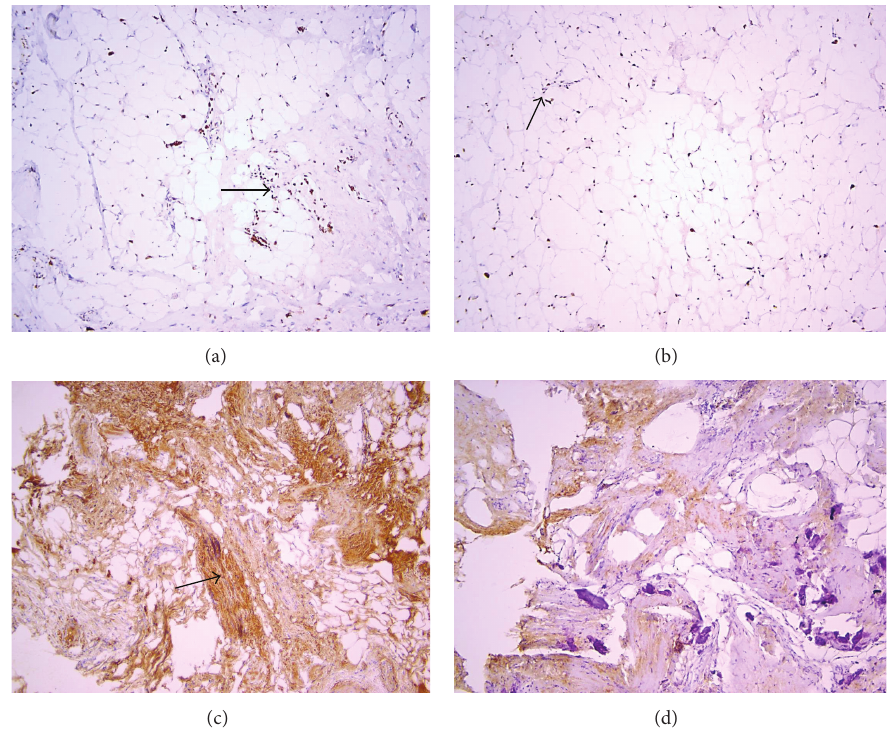
Figure 4: Immunohistochemistry with DAB staining. (a) and (b) FGF- 𝛽 expression observed in the fibroblasts (a) and adipocytes (b) in the connective tissue of the severe GO. Magn. 40x. (c) and (d) A prominent TGF- 𝛽 expression observed in the fibrous connective tissue of the severe (c) and mild (d) GO. Magn.